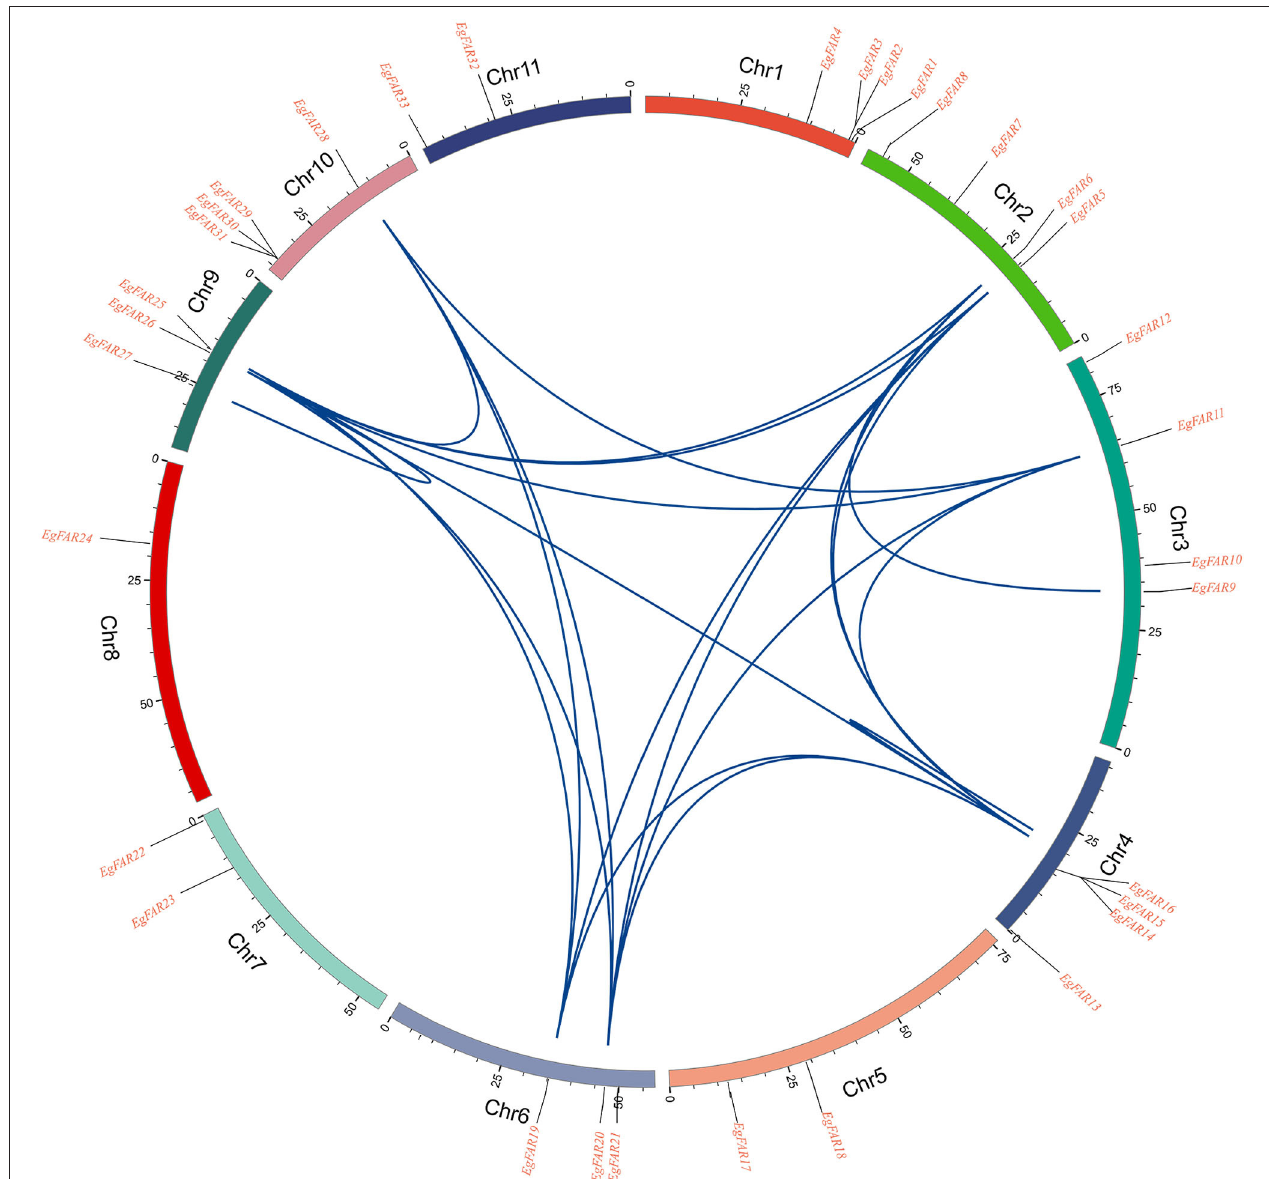
FIGURE 5 | Homologous relationships of FAR1/FHY3 family genes in eucalyptus. Small segments of different colors represent different chromosomes. The genes’ positions on the chromosomes are shown in the corresponding positions on the scale above the small segments. The blue curve represents the correlation between the stages and the genes copied in